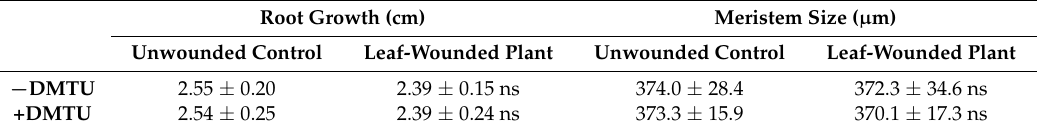
Table 1. Analysis of differences in root growth and meristem size in leaf-wounded seedlings grown in medium with or without the H 2 O 2 -scavenger DMTU. The effect of leaf wounding on root growth was evaluated as the difference between the length measured at the onset of the wounding and that measured after 3 days. The length of the meristematic zone was determined by measuring the distance between the quiescent centre and the first elongating cell in the cortex cell file. These experiments were repeated at least five times with ten seedlings analysed each time (mean values ± SD; n = 50). The statistical significance levels between unwounded control and wounded plants were evaluated by p levels as follows: ns, not